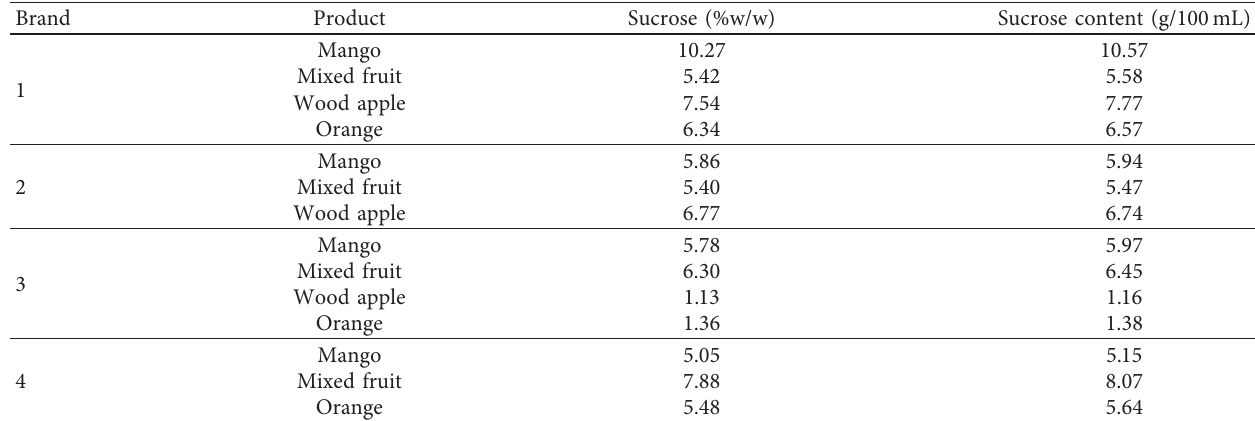
Table 2: Sucrose content in fruit nectars (Lane and Eynon titration method).